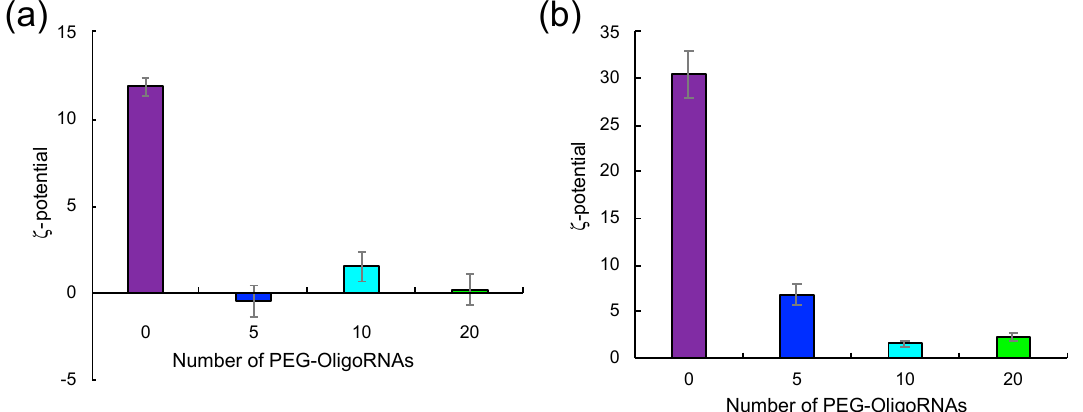
Figure 4. ζ -potential measurement of Lipofectamine LTX/mRNA LNPs. Two LNP formulations were